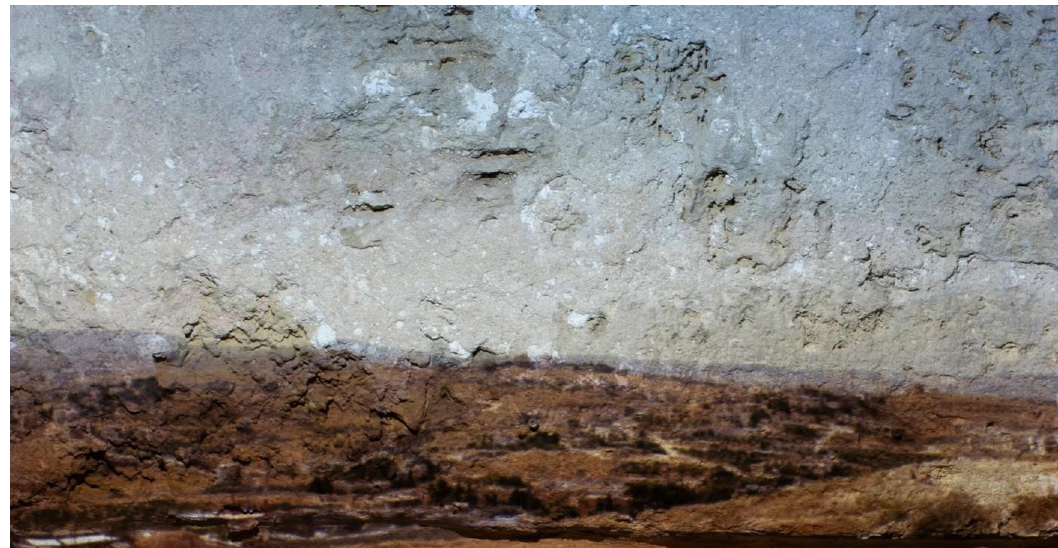
Figure 14: Leor Grady, Untitled ( Bethlehem ) ,